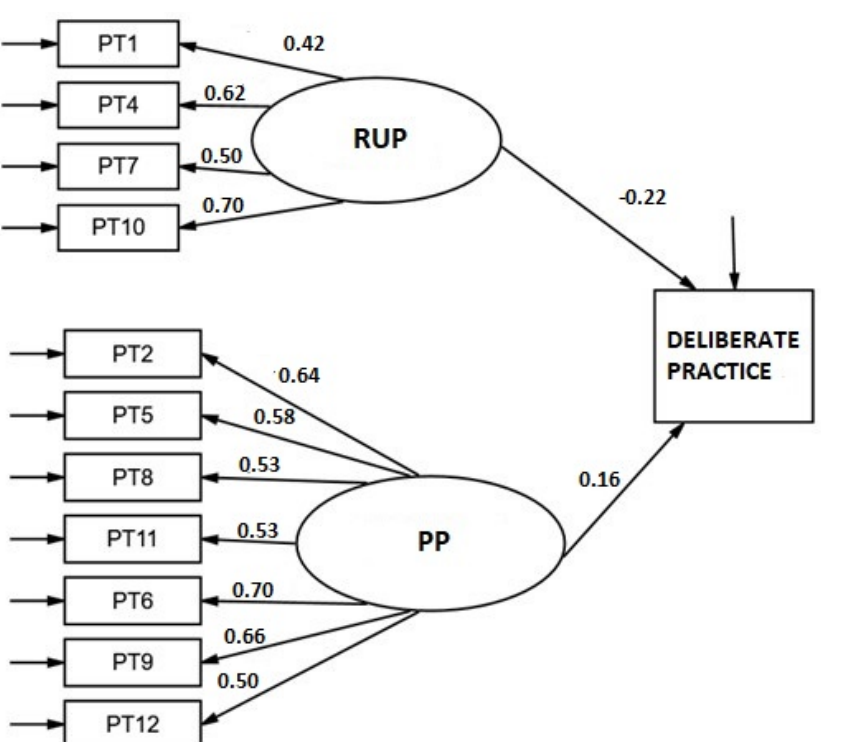
Figure 3. Structural model for the relationship between the latent variables of the Persistence scale and hours of Deliberate Practice. Standardized weights.